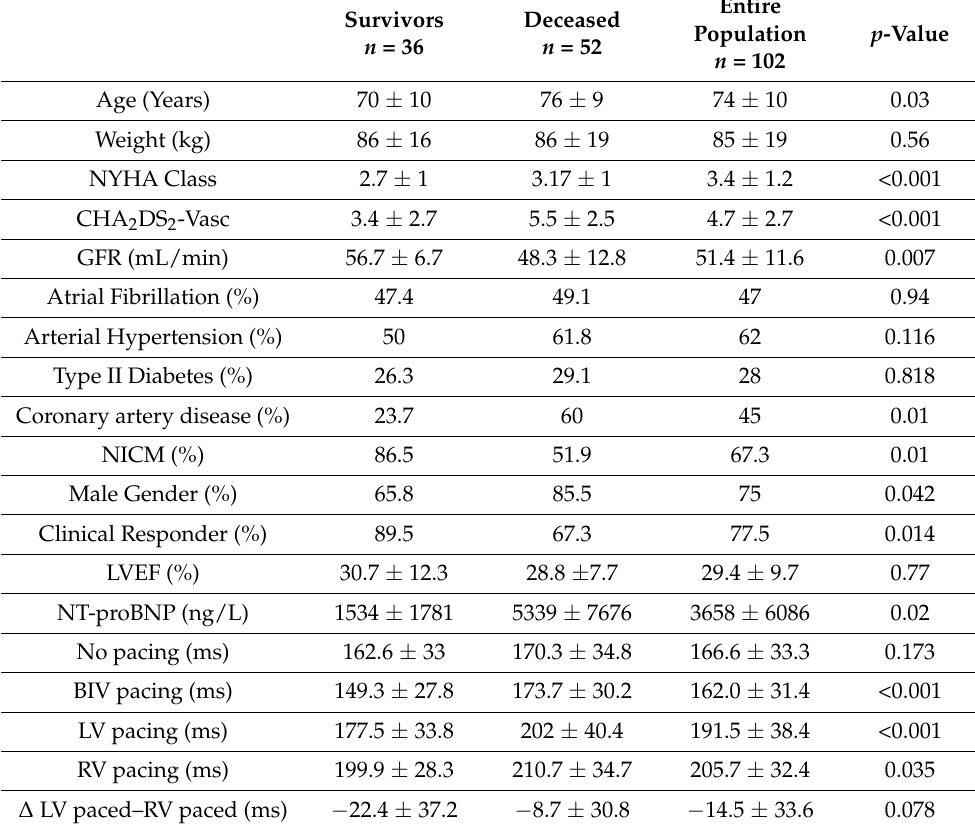
Table 1. Patient characteristics at the time of implantation and ECG parameters (NYHA: New York Heart Association; GFR: glomerular filtration rate; NICM: non-ischemic cardiomyopathy; ng/L: nanogram per liter; LVEF: left ventricular ejection fraction; BIV: bBiventricular; LV: left ventricular; RV: right ventricular; ∆ : difference; ms: milliseconds; kg: kilogram). Survivors n =